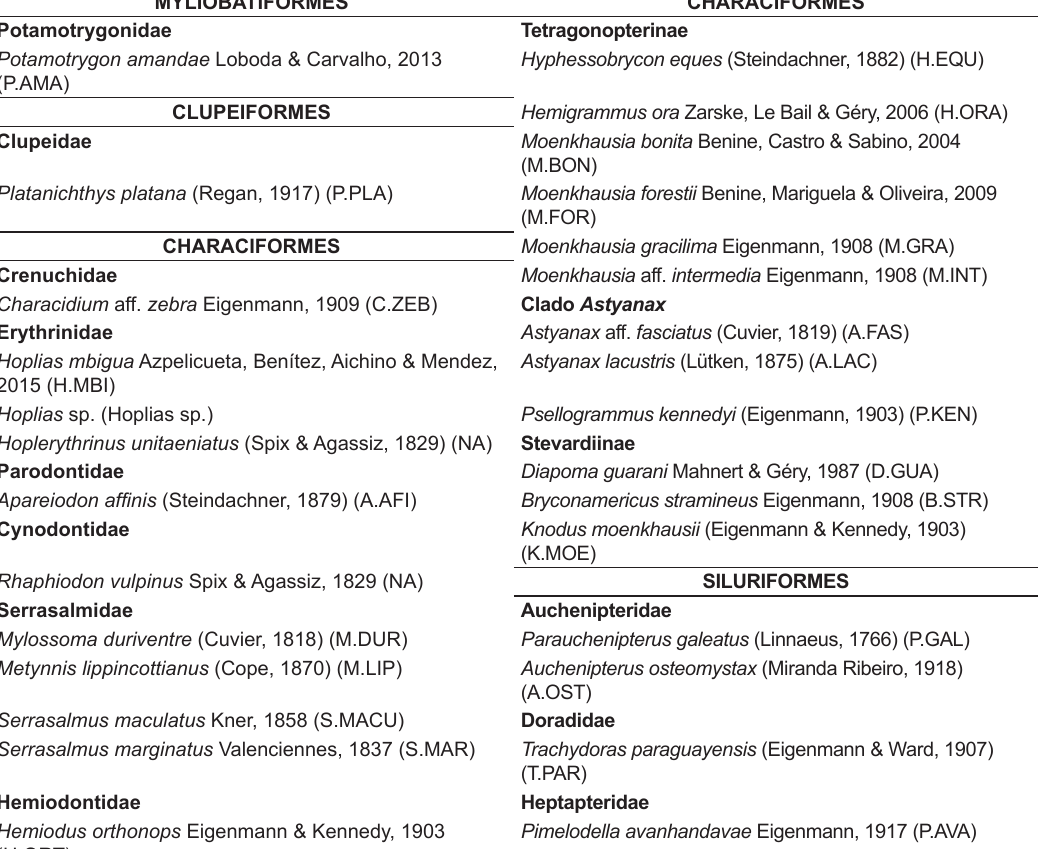
Table 1. Fish species from the upper Paraná River, collected between August 2013 and May 2015. Abbreviations as in NMDS ordination (Figure 3). NA: Not analyzed (species with only one individual, generally a juvenile). Classification follows Eschmeyer & Fong (2017), excepting Characidae subfamilies, which follow Mirande